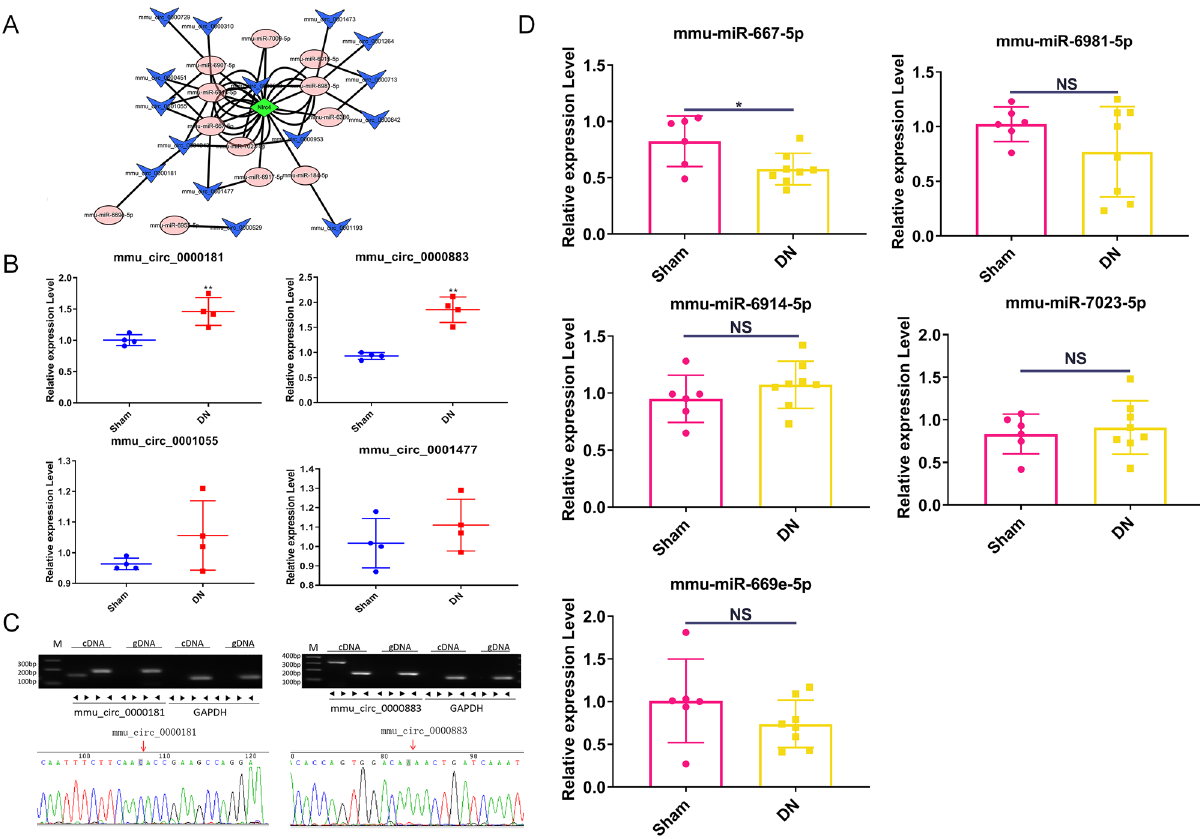
Figure 3. The selection of targeted circRNAs and miRNAs to the NLRC4 gene in the DN model. ( A ) The circRNAs-miRNAs-NLRC4 network was plotted using cytoscape software. ( B ) qPCR analysis was used to detect circRNAs expression in the kidney tissue of sham (n = 4) and DN mice (n = 4). ( C ) The circular structures of circ_0000181 and circ_0000883 were validated via agarose gel electrophoresis and Sanger sequencing. The original images of agarose gel electrophoresis were got ignore the edges visible. ( D ) The expression of miRNAs was detected using qPCR in the kidney tissue of sham (n = 6) and DN mice (n = 8). * P < 0.05; ** P < 0.01. Data are presented as the means ± SD from three independent